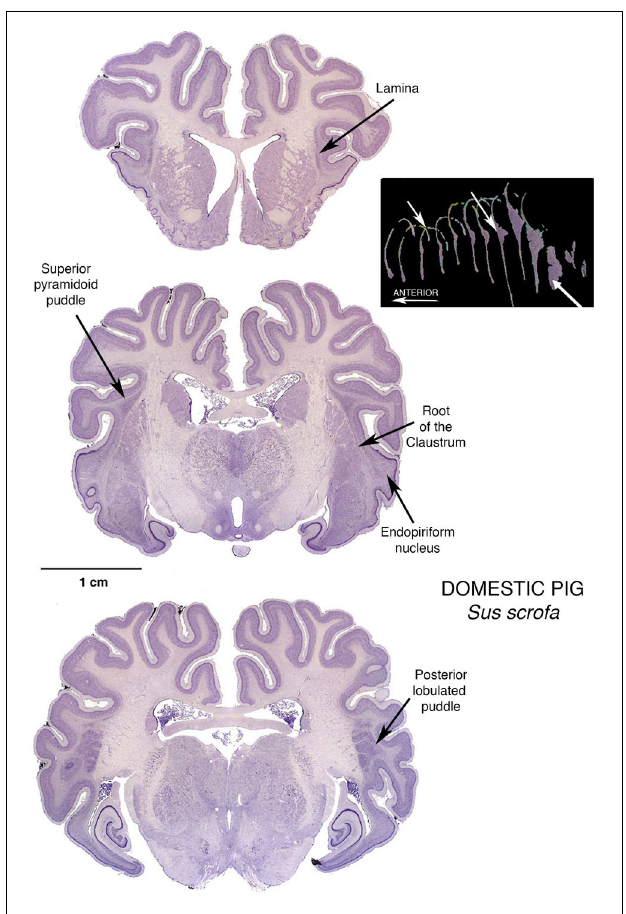
FIGURE 4 | Three Nissl stained coronal sections through the brain of a Domestic Pig, showing a modest Superior Pyramidoid Puddle that abruptly expands, posterior to the caudal limit of the putamen, to form a very large Posterior Puddle. This puddle, seen in this specimen and other published sections from other pigs, has a distinct lobulations into what appear to be four bars of cells, more or less separated from one another. This interesting arrangement is just one of many reasons for further investigation: if the claustral mass is sufficiently large, are there internal structural or functional reasons for assuming a particular shape? The 3-dimensional reconstruction in this figure is by Kenneth Buchanan.